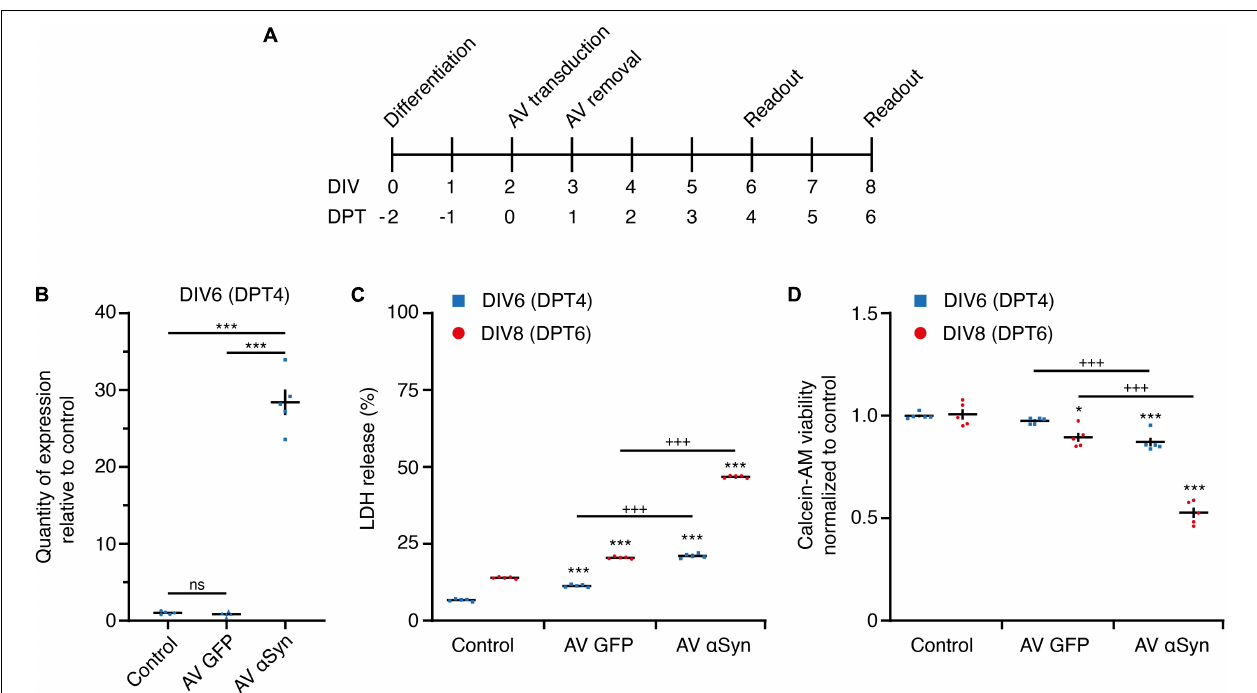
FIGURE 2 | In vitro SNCA overexpression model. (A) In vitro treatment scheme. LUHMES neurons were transduced with adenoviral (AV) vectors of SNCA or GFP (control virus). DIV, days in vitro ; DPT, days post transduction. (B) Expression of SNCA mRNA in LUHMES neurons after 4 days of transduction with GFP AV or SNCA AV vectors. (C) Cytotoxicity measured by release of lactate dehydrogenase (LDH) at indicated read-out times in untreated cells (control) and cells transduced with AV GFP (virus control) or AV SNCA. LDH release is expressed as percentage of lysed cells (positive control). (D) Cell viability measured by intracellular hydrolysis of calcein acetoxy methyl (-AM) ester at indicated read-out times in untreated cells (control) and cells transduced with AV GFP (virus control) or AV SNCA. Data of AV GFP and AV SNCA were normalized to the respective readout control, set as one. Results are presented as mean ± SEM from at least three biological repeats. Statistical analysis in panel (B) was Students t -test and in panels (C,D) ordinary two-way ANOVA with Bonferroni’s multiple comparison test. +++ P < 0.001; * P < 0.05, *** P < 0.001 vs. respective